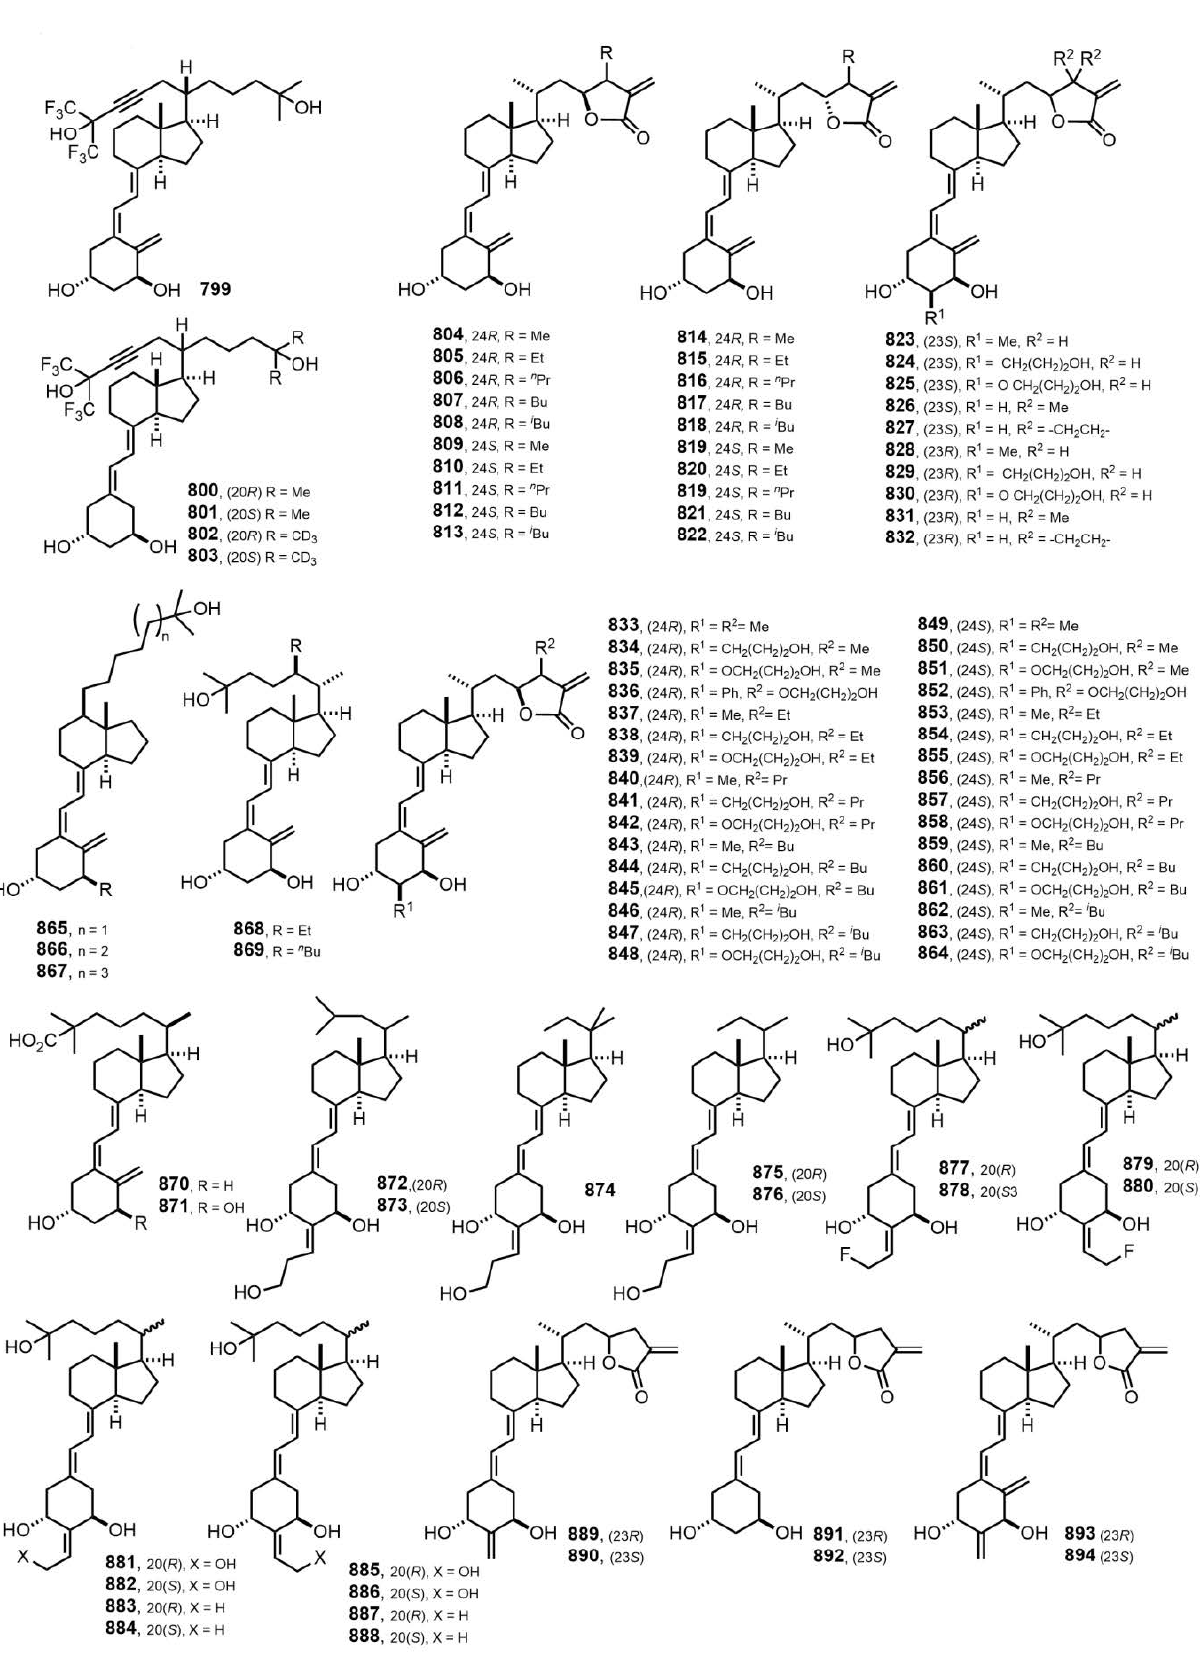
Figure 16. (2006-2008) [241 – 253].